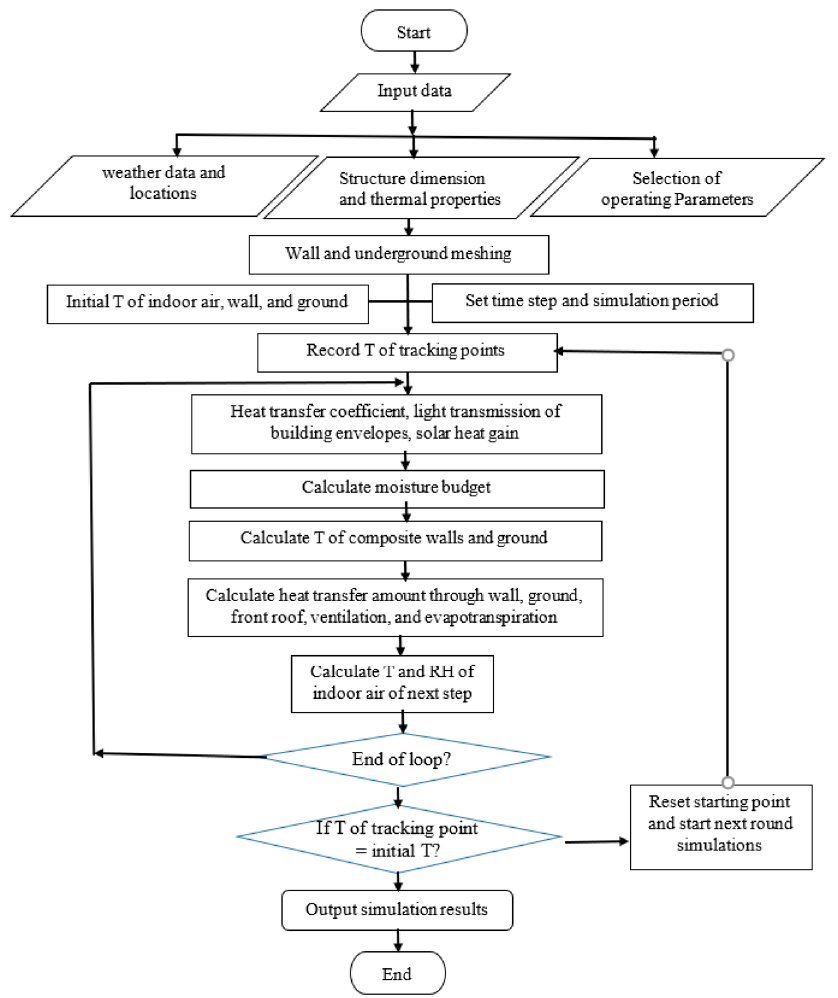
Figure 1. Simulation flow chart of the SOGREEN